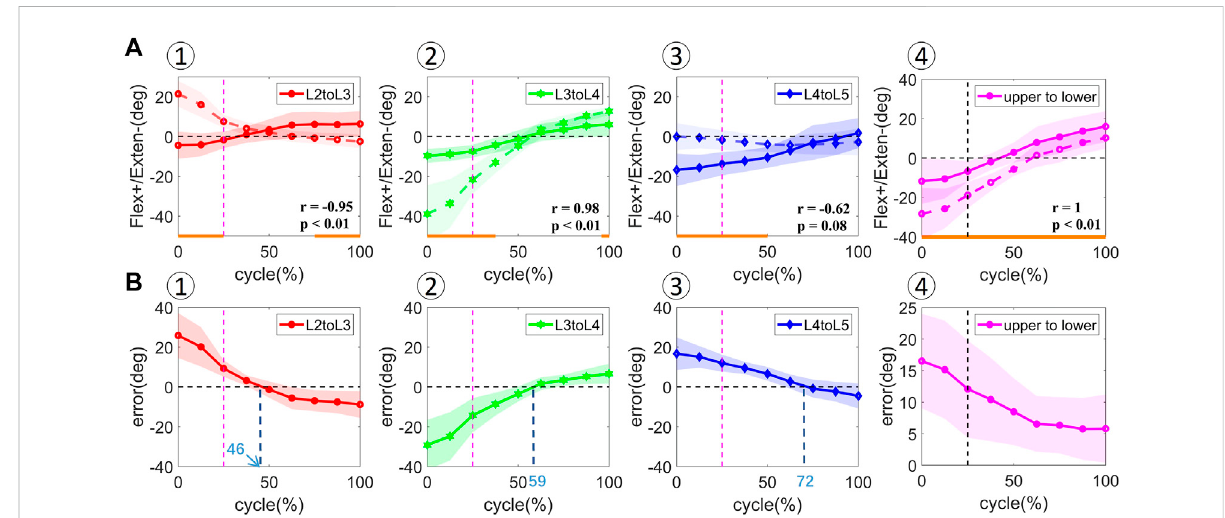
FIGURE 4 [ (A) ① – ④ ] In vivo kinematics measured by two measurements at adjacent vertebral levels (L2 – L3, L3 – L4, L4 – L5) and upper and lower lumbar levels (upper to lower). The solid line represents themean valuesfor all thesubjects measured by DR. The dotted line represents the mean values for all thesubjects measured byskin markers. Statistical signi fi cance between thetwo measurements is marked bythe solidorangeline along the x -axis of top-row graphs. [ (B) ① – ④ ] Rotational error at adjacent vertebral levels (L2 – L3, L3 – L4, L4 – L5) and upper and lower lumbar levels (upper to lower). The shaded area represents the standard deviation of the